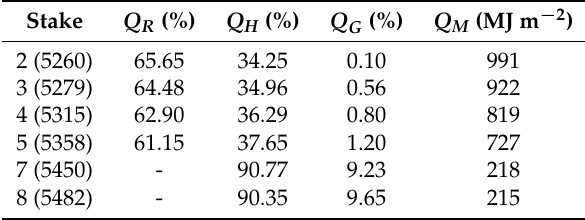
Table 3. Total contribution of energy balance components to the surface melting at various stake Figure 3. Daily mean values of energy balance components at stake locations 3 and 8 of Yala Glacier locations on Yala Glacier for the period of 5 May 2014–15 November 2014 (196 days). Values in brackets are the altitude of each stake in m